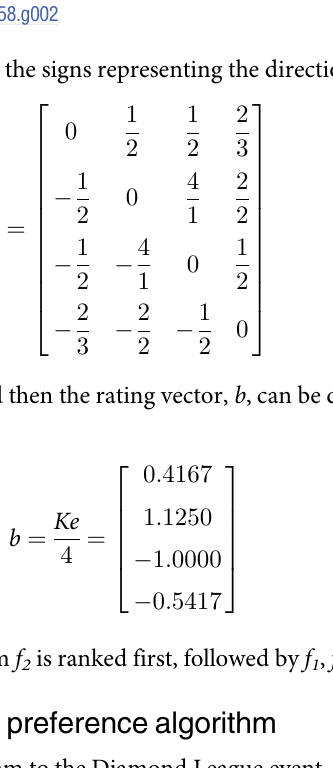
Fig 2. Graph for user preference rating example. The nodes represent the films and the edgesrepresent the user ratings, with edge scores representingthe numericaldifference betweenthe user ratings for the two